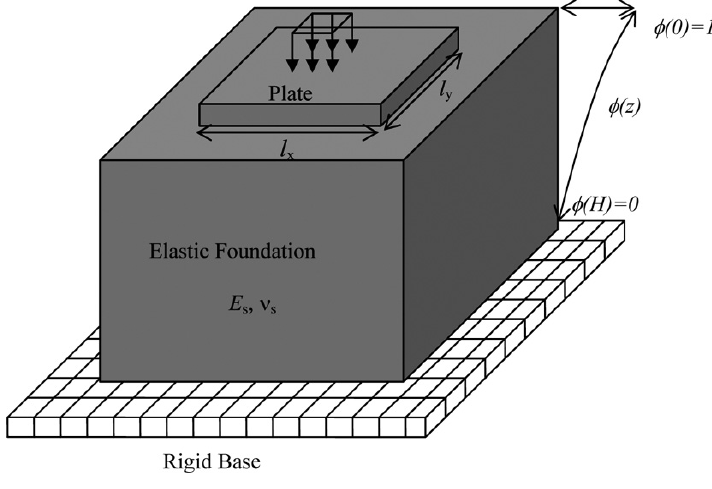
Fig. 1. A plate resting on an elastic